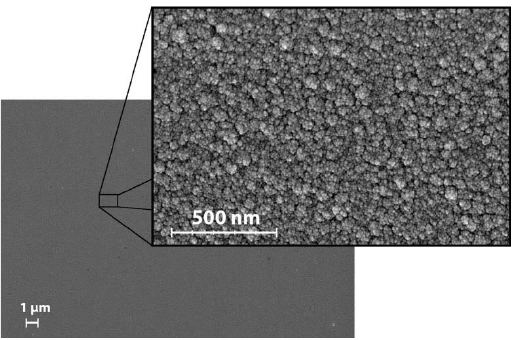
Figure 6. SEM images of the surface in point 1. All points exhibited a similar appearance.